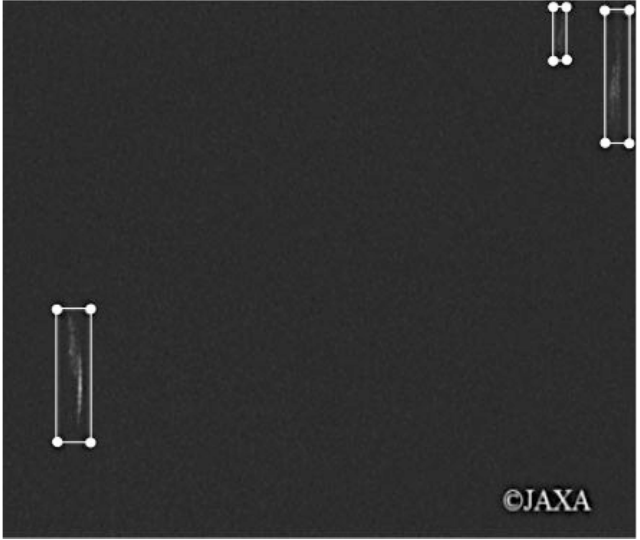
Figure 3. Annotation for the images of moving ships. The white bounding boxes are the annotation for creating the training model.